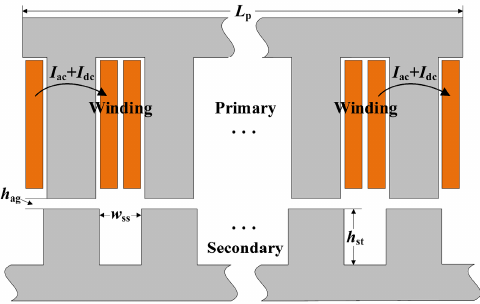
Figure 1. Structure and parameters of DCB ‐ VRLMs.